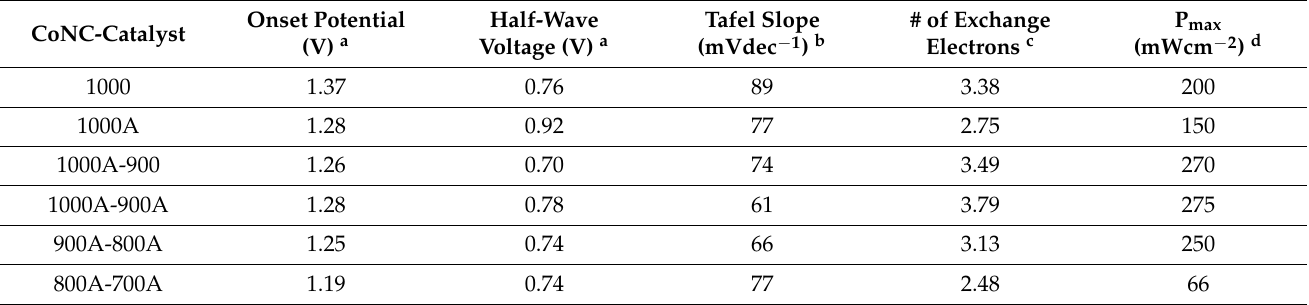
a : obtained from LSV curves in Figure 9. b : obtained from curves in Figure 10a. c : obtained from curves in Figure 10b. d : obtained from Figure 11.